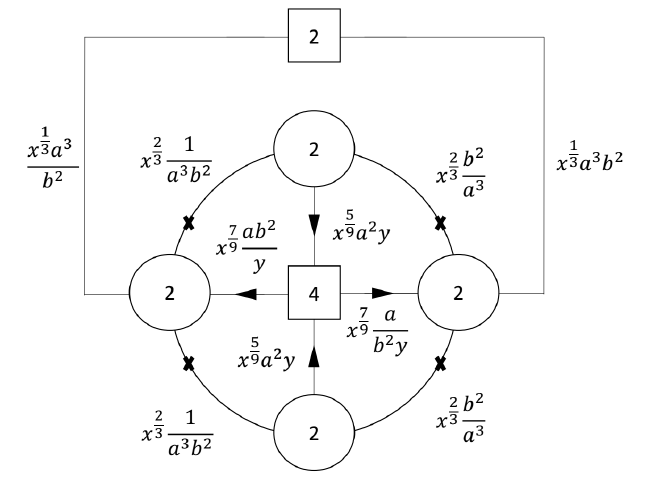
Figure 5 . The 3 d quiver theory associated with the compactification of the 5 d E 7 SCFT on a torus √ with flux ( 2; 1 , 1 , 1 , 1 , 0 , 0) . In the figure we have used fugacities to represent the charges of the fields under the global symmetries, specifically, the fugacities a , b and y for the three U(1) global symmetries and x for the R-symmetry. The theory also contains various superpotential interactions, which corresponds to all operators build from the fields that carry R-charge 2 and are global symmetry singlets. For completeness, we note that these include the four cubic superpotentials running along the triangles, the flipping superpotentials and two quadratic superpotentials running along the two bifundamentals connected to the global SU(2) in the upper square and the upper and lower semi-circles. Finally, there are four monopole superpotential of the type (1 , 1) for all adjacent SU(2)